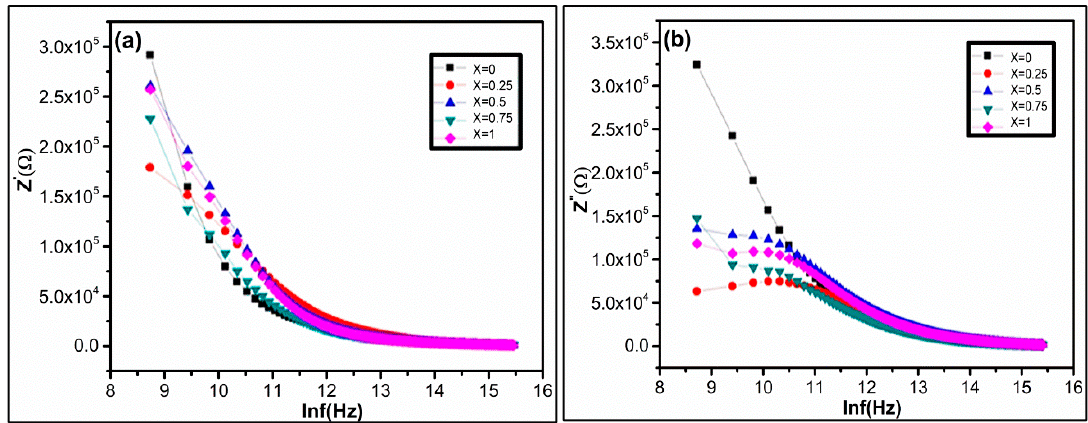
Figure 9. Variation of ( a ) real part and ( b ) imaginary part of impedance z ′ as a function of lnf(Hz) of Ni 1-x Zn x Fe 2 O 4.